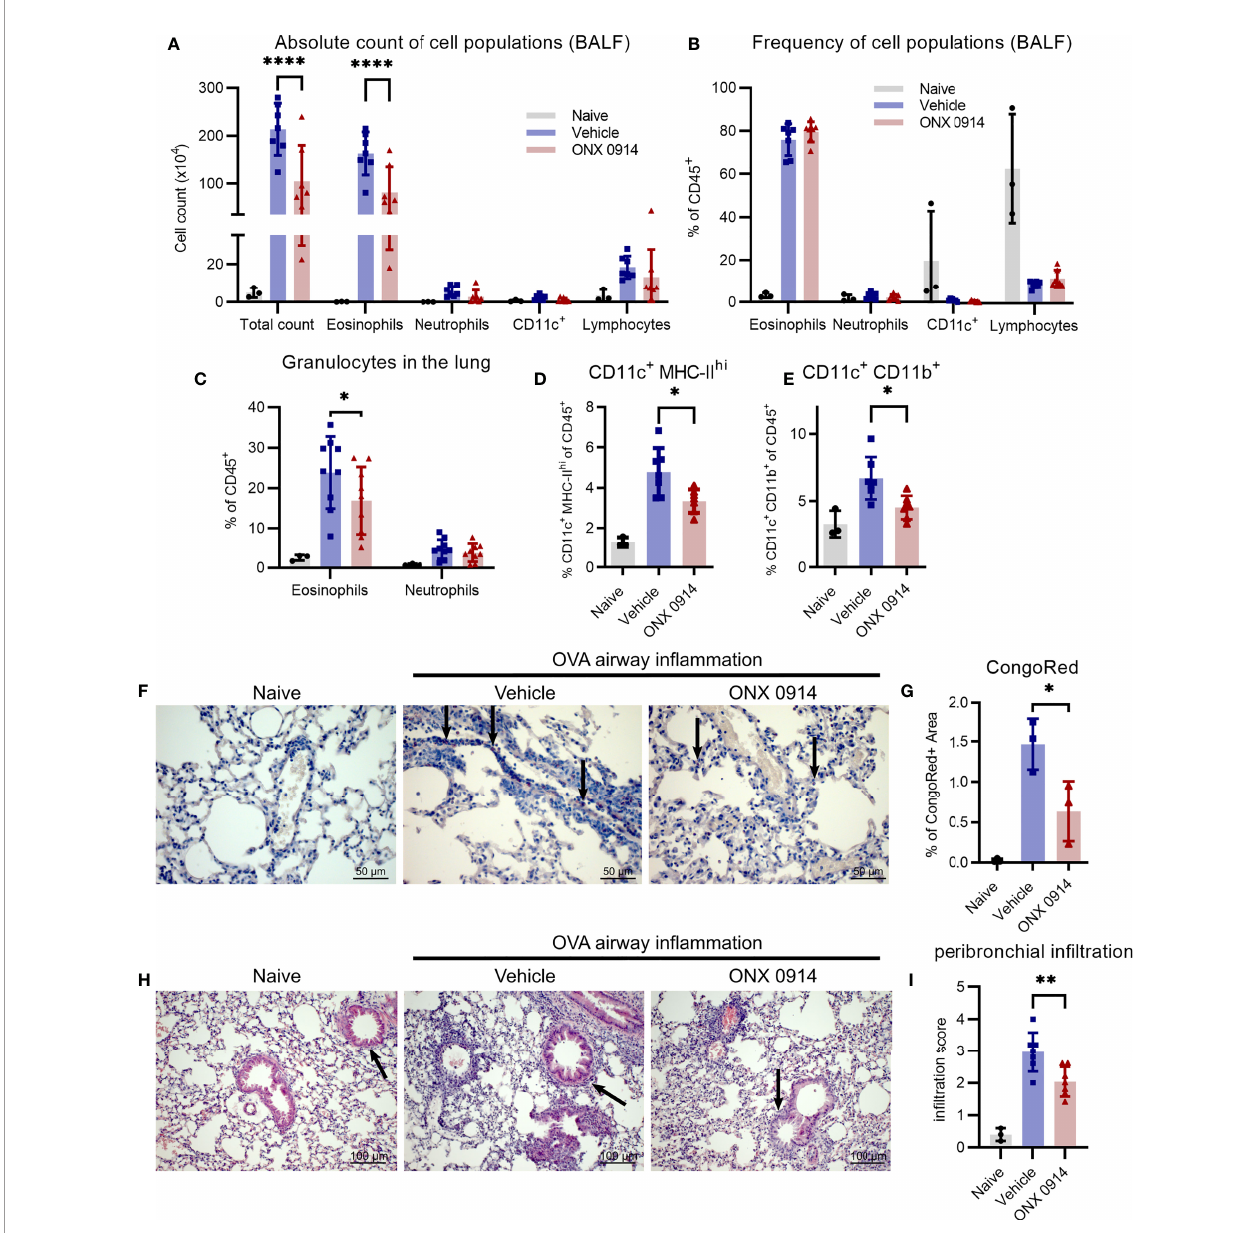
FIGURE 4 | In fi ltration of in fl ammatory cells is reduced upon ONX 0914 treatment in OVA-induced airway in fl ammation. GATIR mice were sensitized with OVA/Alum by two intraperitoneal (i.p.) injections on day 0 and 7. On day 14, 15 and 16 they were challenged with aerosolized OVA for 20 min. Mice received subcutaneous injections of 10 mg/kg ONX 0914 or vehicle on day 12, 14, 15 and 16 and were analyzed on d17. Naïve mice served as controls. (A, B) In fi ltrating cells in the broncho-alveolar lavage fl uid (BALF) were analyzed by fl ow cytometry. (A) Absolute cell count and (B) relative frequency of the different cell populations identi fi ed as eosinophils (CD45 + CD11c - CD11b + Ly6G - Siglec-F + ), neutrophils (CD45 + CD11c - CD11b + Ly6G + ), CD11c + and lymphocytes (CD45 + CD11b - SSC-A low ) (naïve: n=3; vehicle/ONX 0914 n=7). Single cell suspensions from lungs were analyzed by fl ow cytometry and cells were identi fi ed as (C) eosinophils (CD45 + CD11c - CD11b + Ly6G - Siglec-F + ) and neutrophils (CD45 + CD11c - CD11b + Ly6G + ) (naïve: n=3; vehicle/ONX 0914 n=9) as well as (D, E) different CD11c + subpopulations (naïve: n=3; vehicle/ONX 0914 n=7). (F, G) Formalin- fi xed sections were stained with CongoRed and the positive area was quanti fi ed by color deconvolution. Arrows indicate CongoRed-positive cells, representing eosinophils. Scale bar indicates the distance of 50 µm. Data is shown as a representative of two independent experiments with similar results (n=3). (H, I) Hematoxilin-eosin-staining of formalin- fi xed samples, scale bar indicates the distance of 100 µm (naïve: n=3; vehicle/ONX 0914 n=7). All data is shown as mean ± SD and was pooled from 2-3 independent experiments (except G ). Signi fi cance of differences was analyzed by two-way (A-C) or one-way (D-I) ANOVA with Holm-Sidak test for multiple comparison. *p <0.05, **p < 0.01, and ****p < 0.0001. For better visibility, only the results for the comparison Vehicle vs. ONX 0914 are